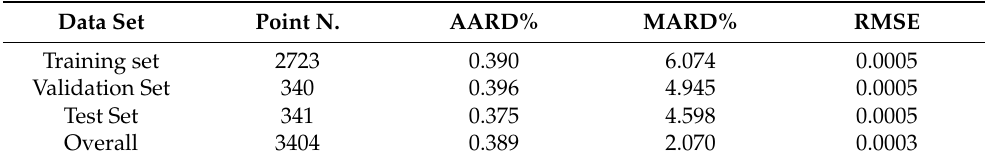
Figure 2. Absolute average percent deviation between data collected and the ANN results vs. the number of neurons in the hidden layer. Table 3. Statistical parameters for the individual datasets including the training set, validation set, test set, and the entire dataset.